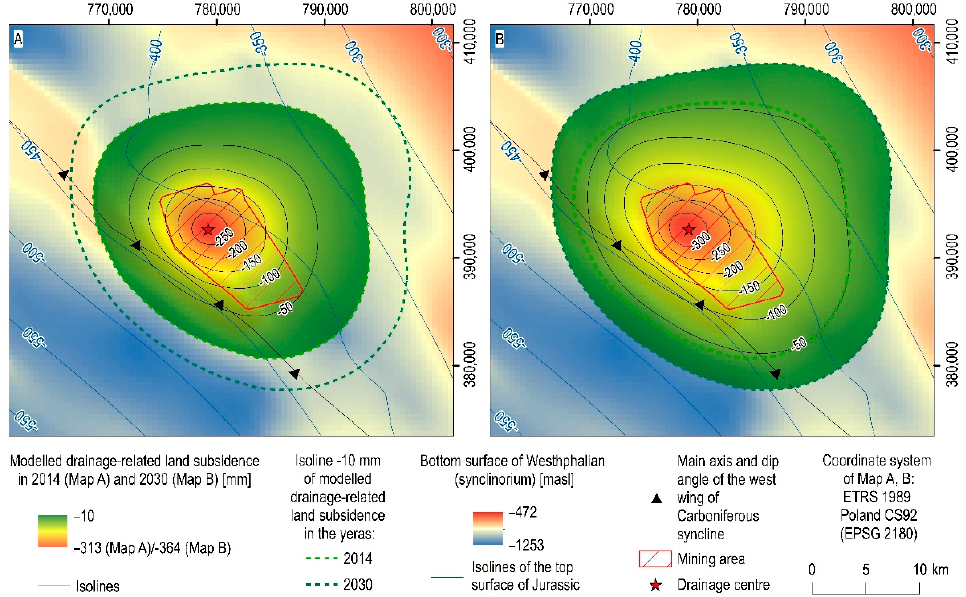
Figure 10. The spatial distribution of mining drainage-induced land subsidence in the “Bogdanka” mine area in ( A ) 1981–2014 and ( B ) 1981–2030, as estimated using the Knothe influence function method.